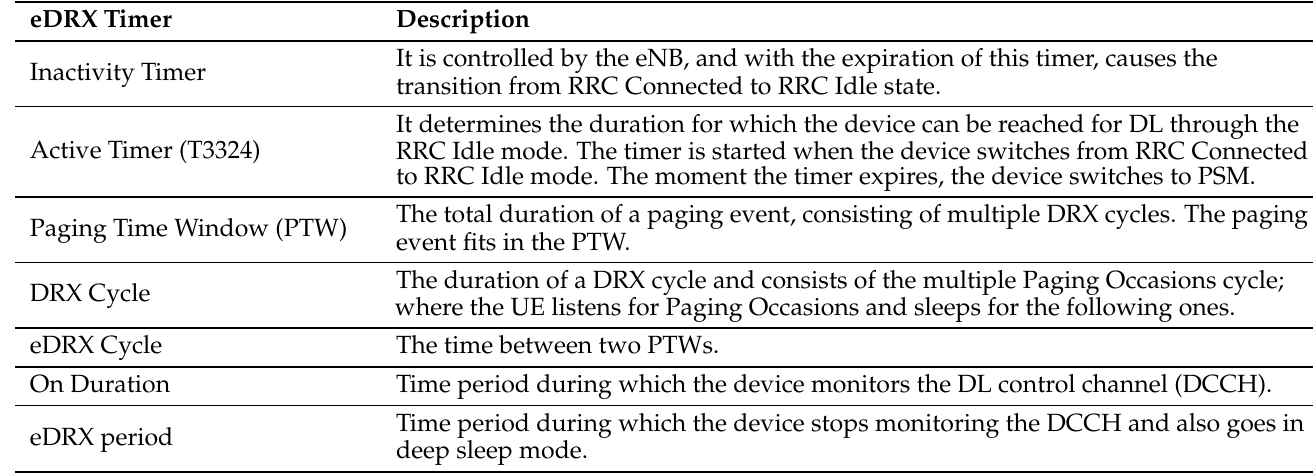
Figure 9. Power Saving Mode (PSM) and extended Discontinuous Reception (eDRX) mechanisms in NarrowBand IoT (NB-IoT). Table 6. eDRX